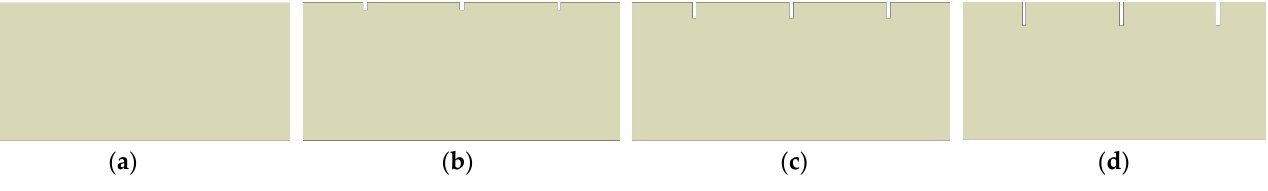
Figure 17. Uniaxial stress–strain curve for concrete ( a ); stress–strain curve for wires ( b ) [40].